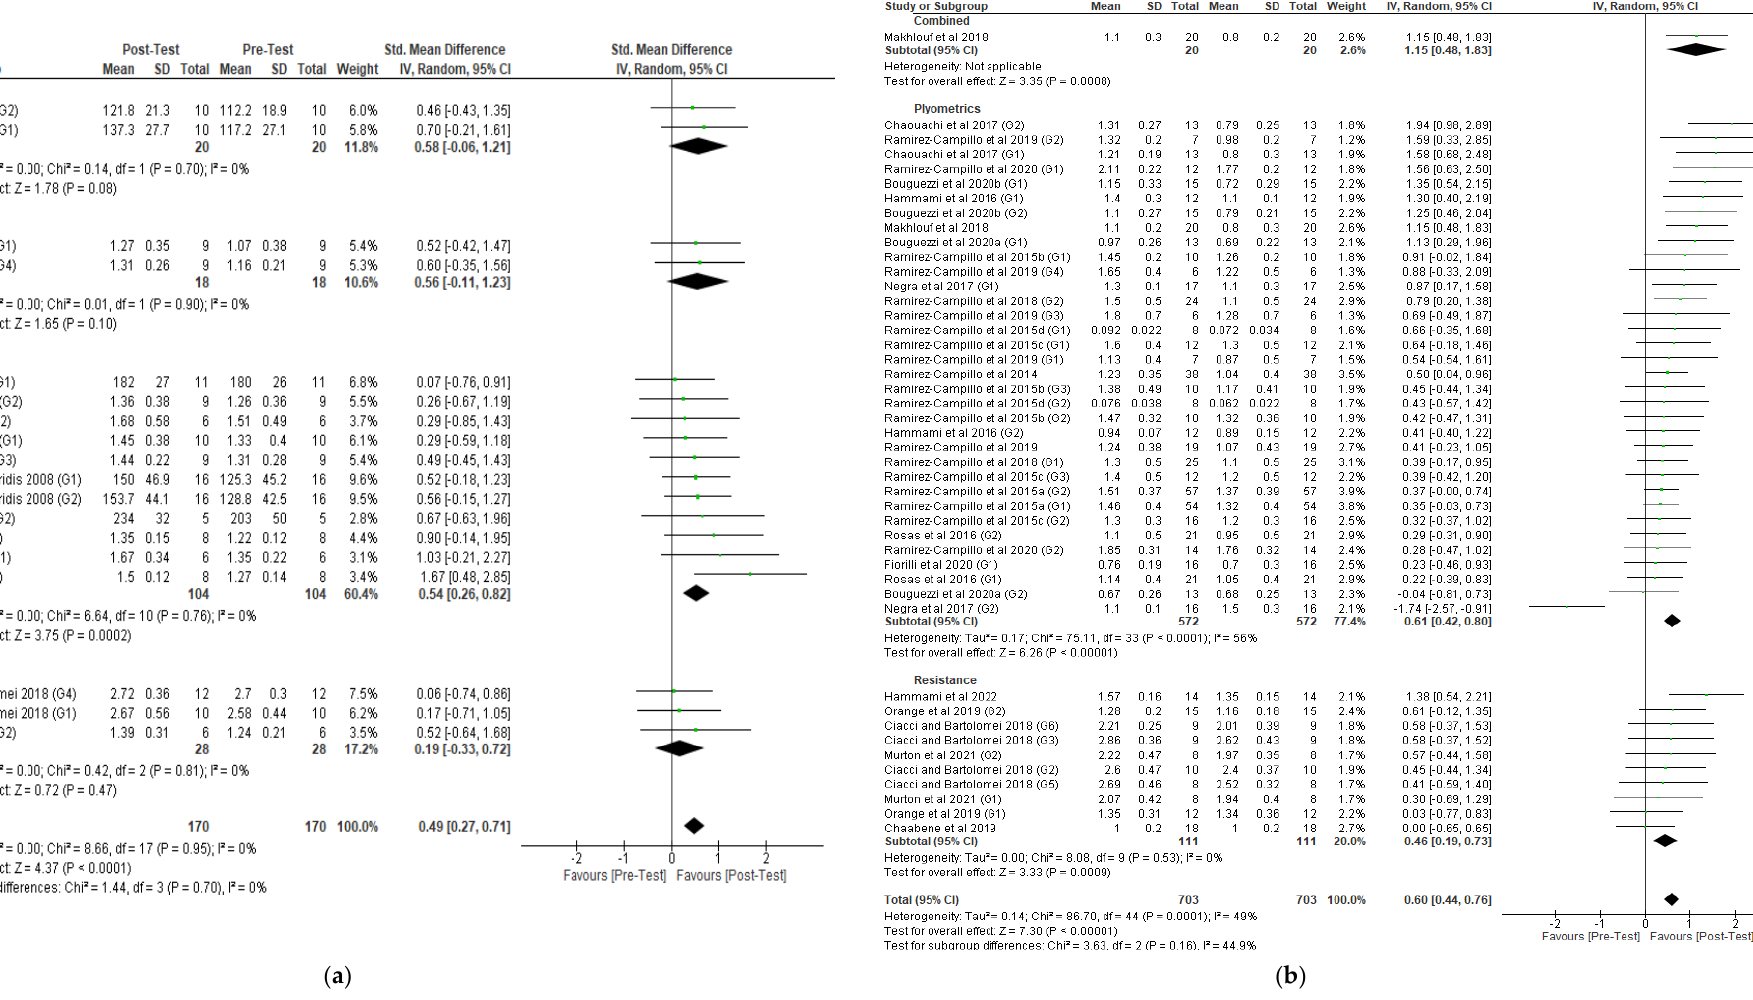
Figure 4. Forest plot, ranked by treatment effectiveness (the size of the green dot corresponds to the weight of the study within the meta-analysis), regarding ( a ) adult and ( b ) youth athletes.